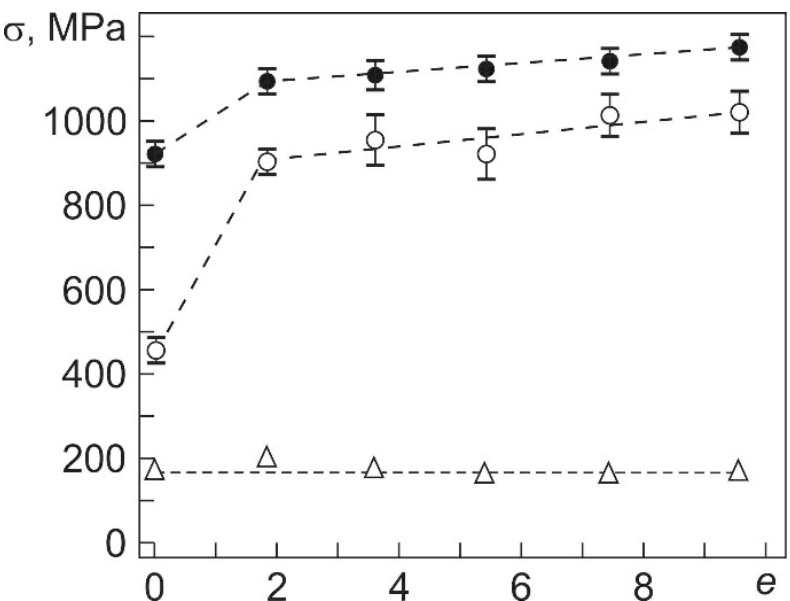
Figure 6. Pseudoyield plateau stress, σ m ( Δ ), yield stress, σ y ( ο ), and ultimate tensile strength, σ UTS ( ● ), vs. the true abc-strain, e . Experimental errors of the pseudoyield plateau stress equal ± 20 MPa. The stress at the beginning of the pseudoyield plateau σ m for all samples turned out to be almost the same. Since at the test temperature, all the obtained samples